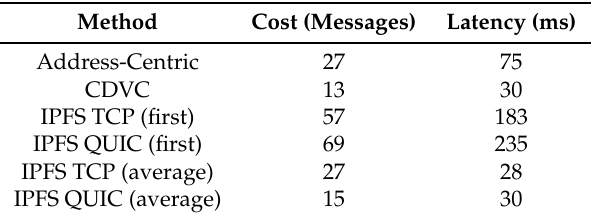
Table 2. Content delivery